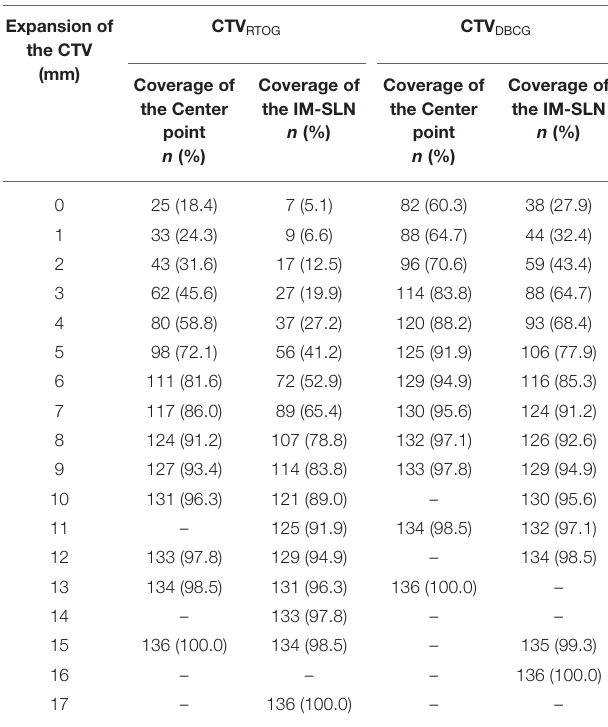
TABLE 2 | After different expansions of the CTV RTOG and CTV DBCG, the coverage rate of the center point IM-SLNs and the whole volume